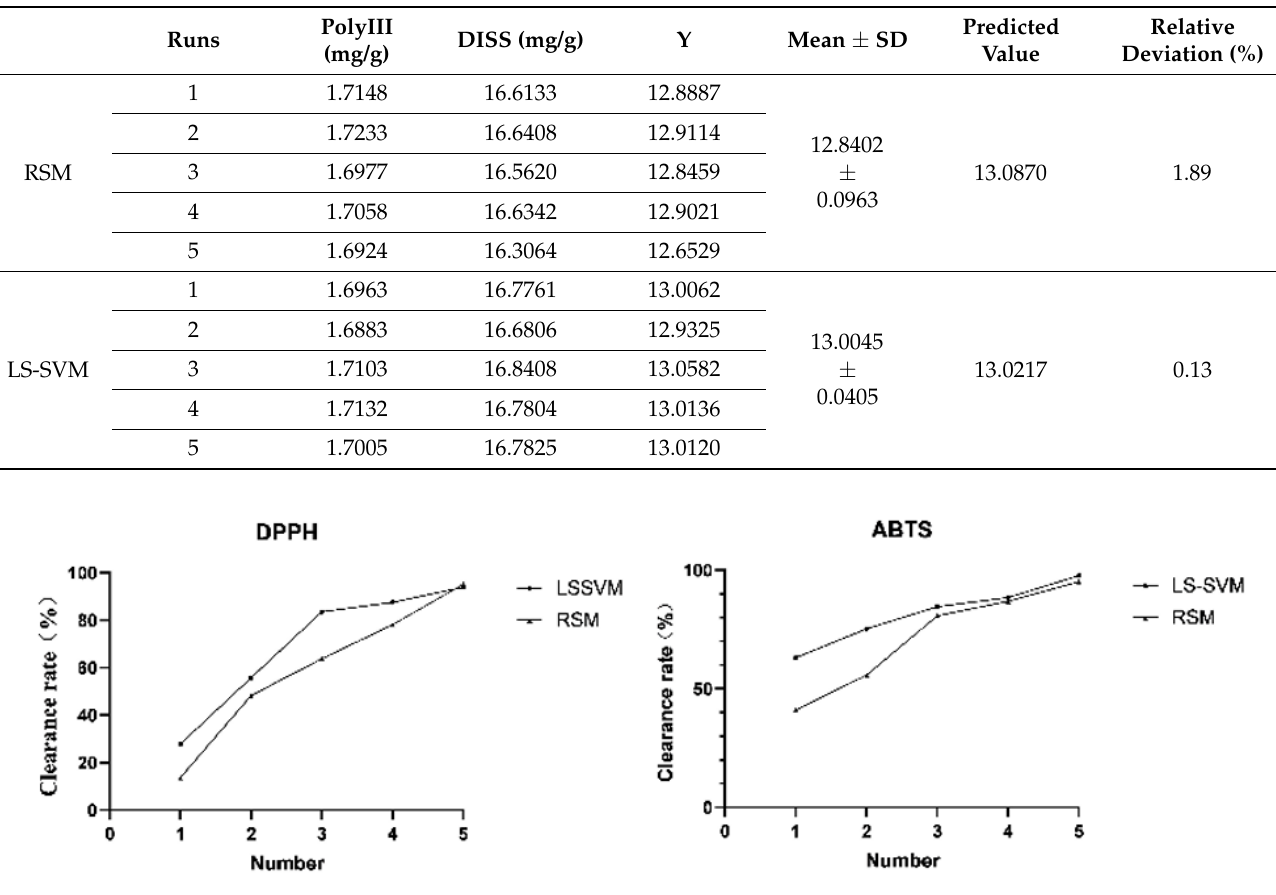
Figure 6. Antioxidant activity of Yuanzhi extracts.